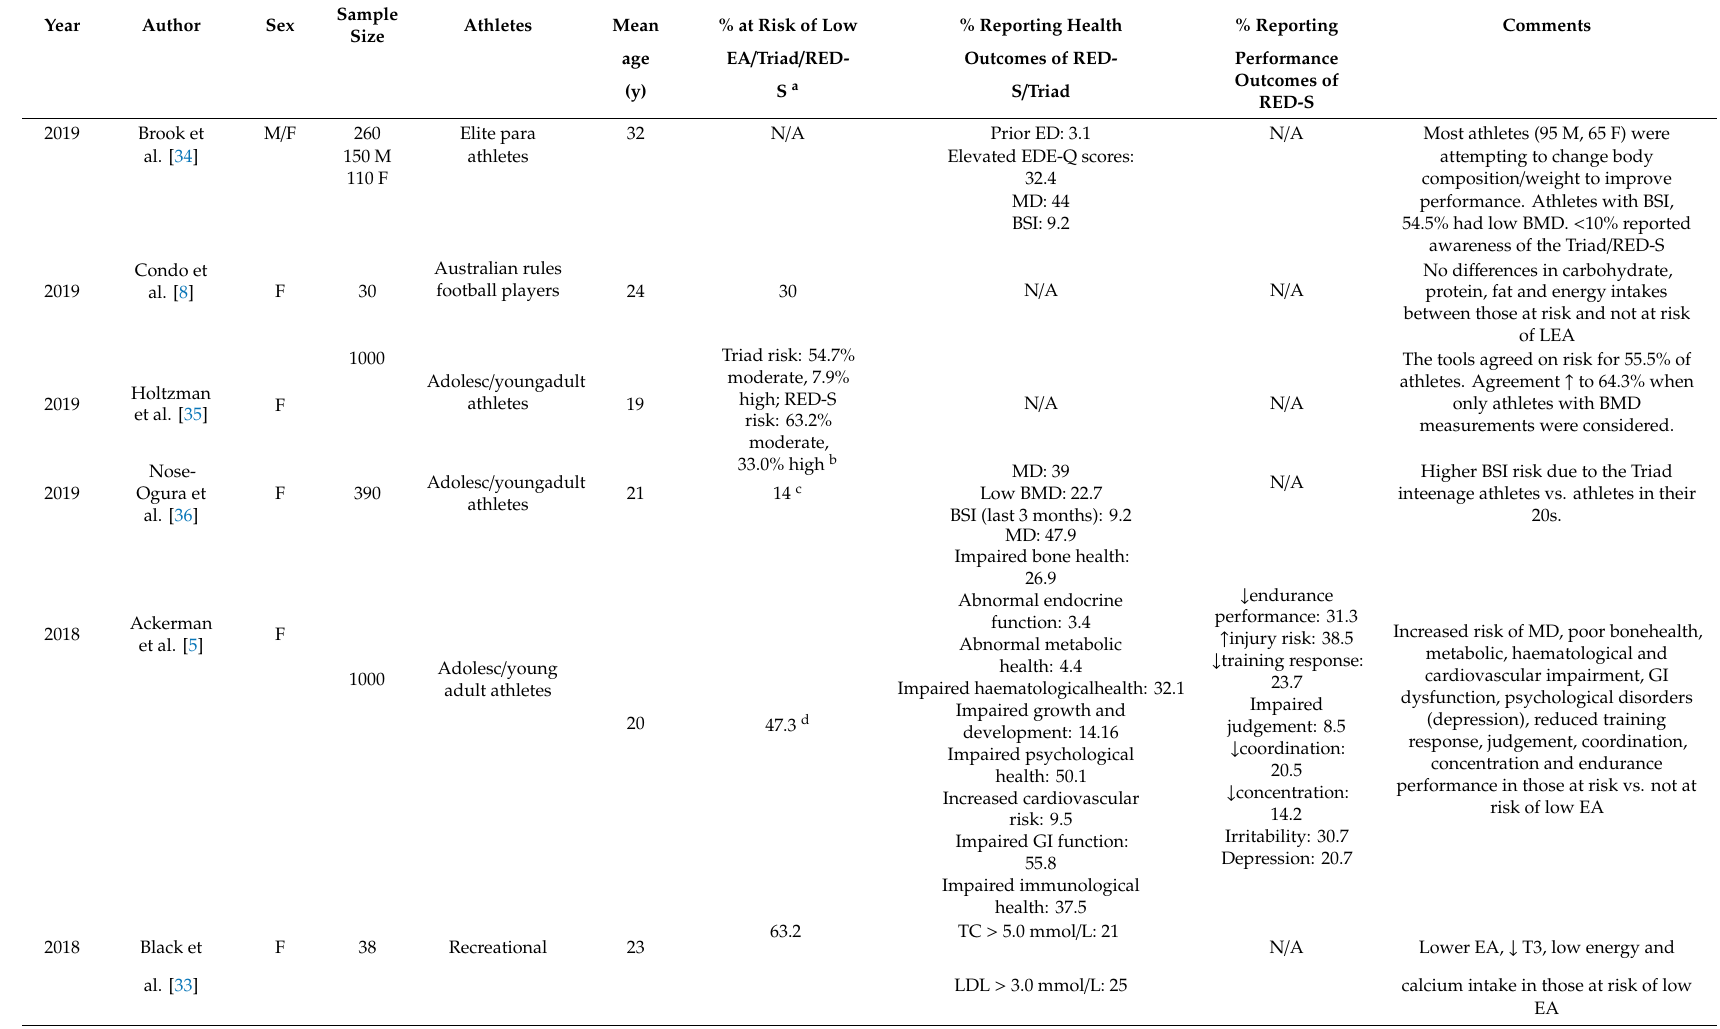
Table 3. Estimated risk of low energy availability and associated health and performance